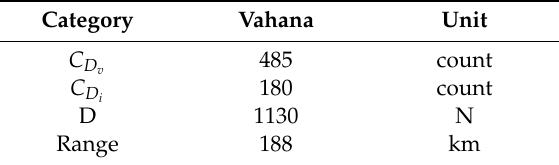
Table 12. Drag and range of Vahana.